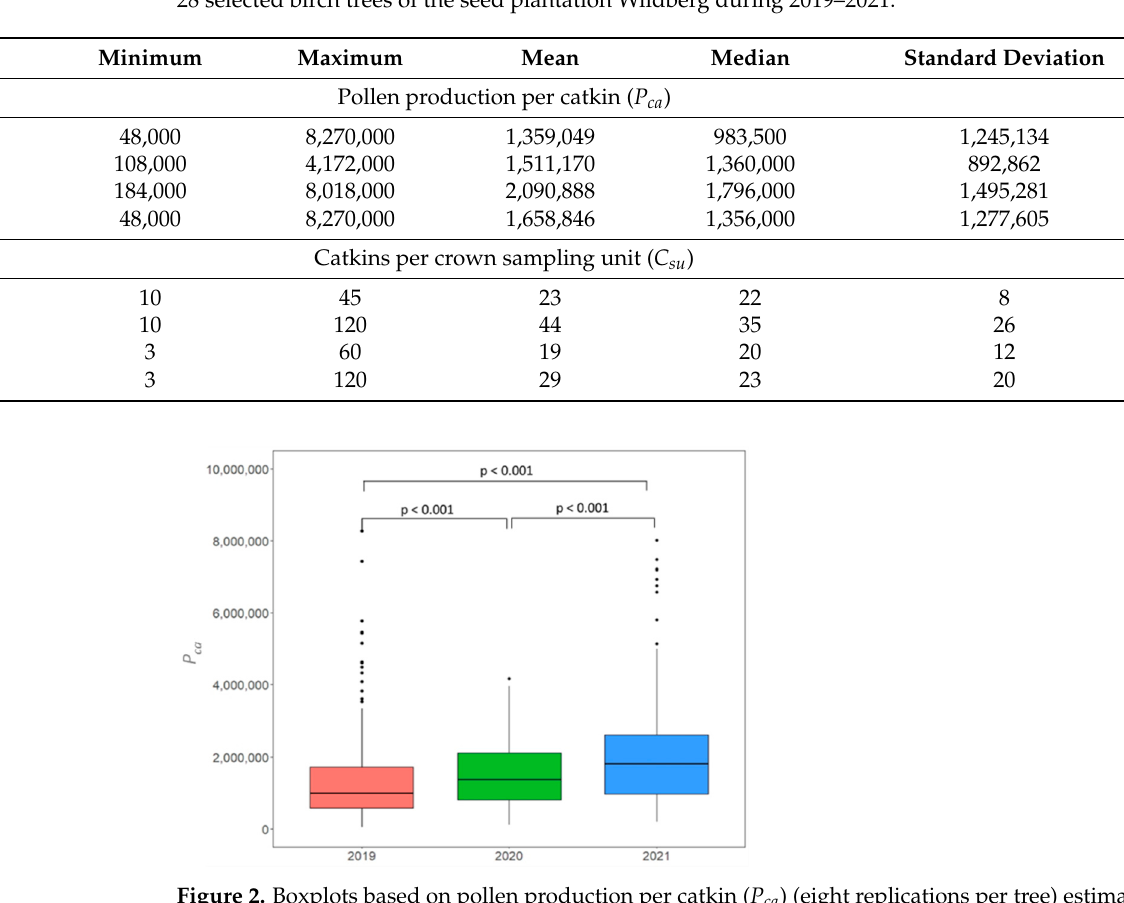
Table 3. The highest Spearman’s correlation coefficient was found for P fl and P ca (r s = 0.980, p < 0.001). fl was associated with a negative correlation with P fl ( r s = − 0.230, p < 0.001) and a positive correlation with C su ( r s = 0.200, p < 0.001). P fl or P ca did not show any significant